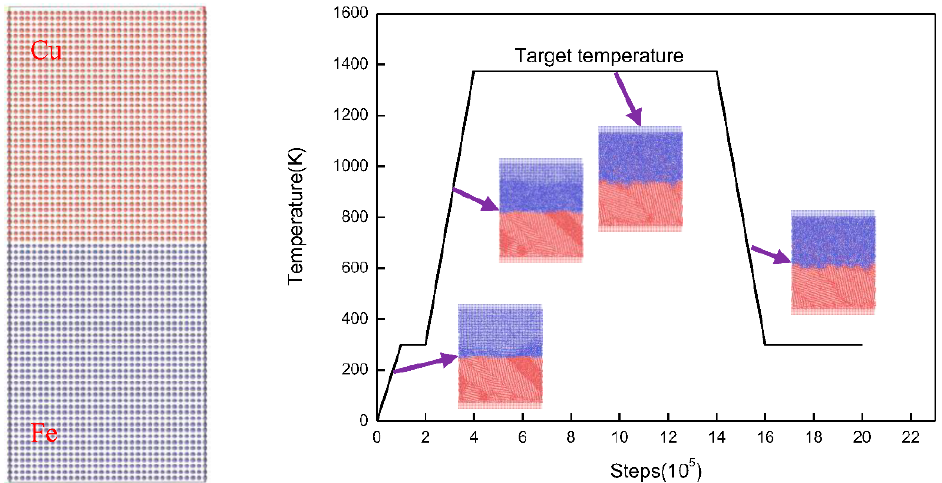
Figure 1. Atomic configuration of Fe/Cu interface model and the temperature–time relationship of the diffusion process.